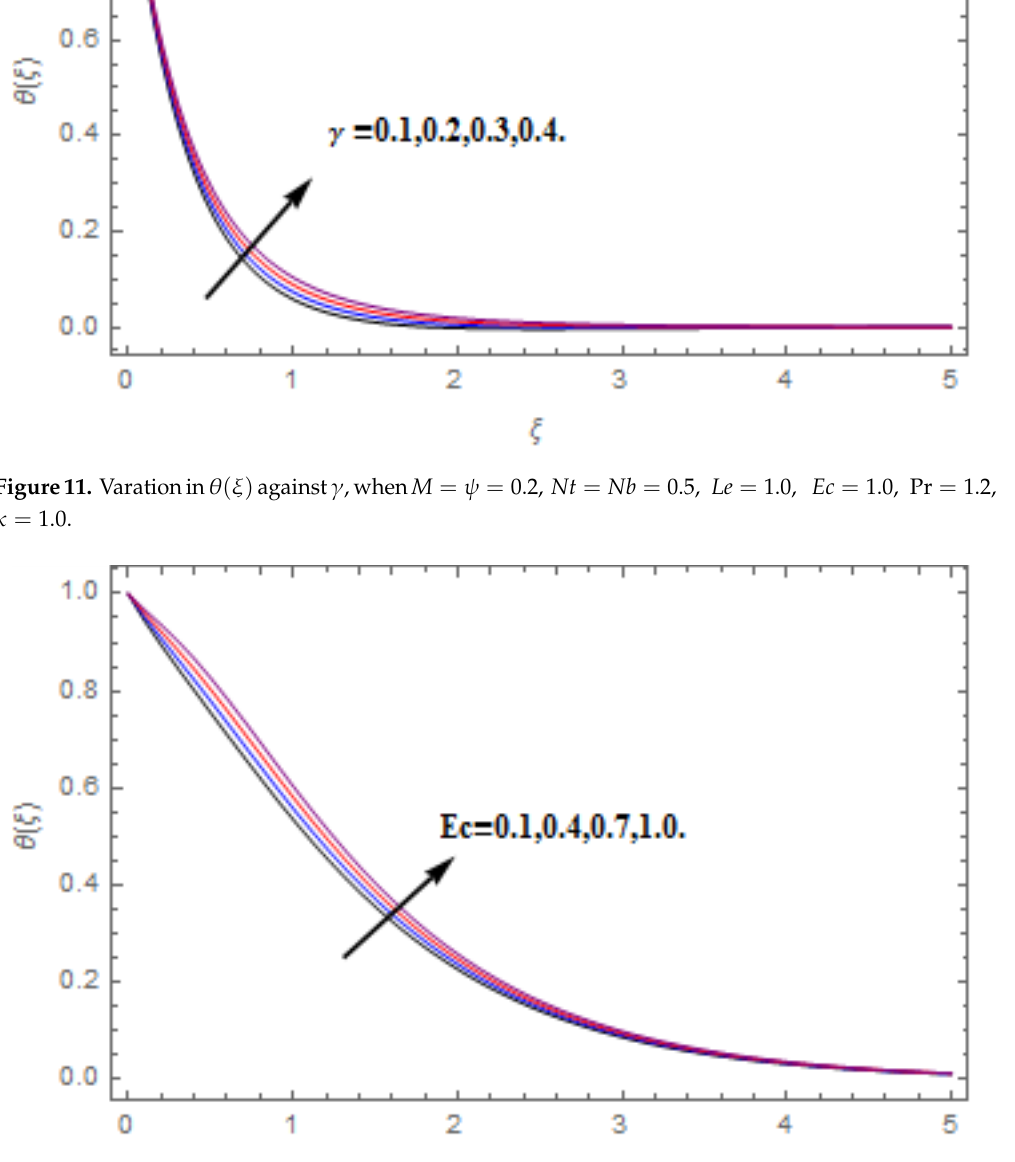
    against Ec , when .